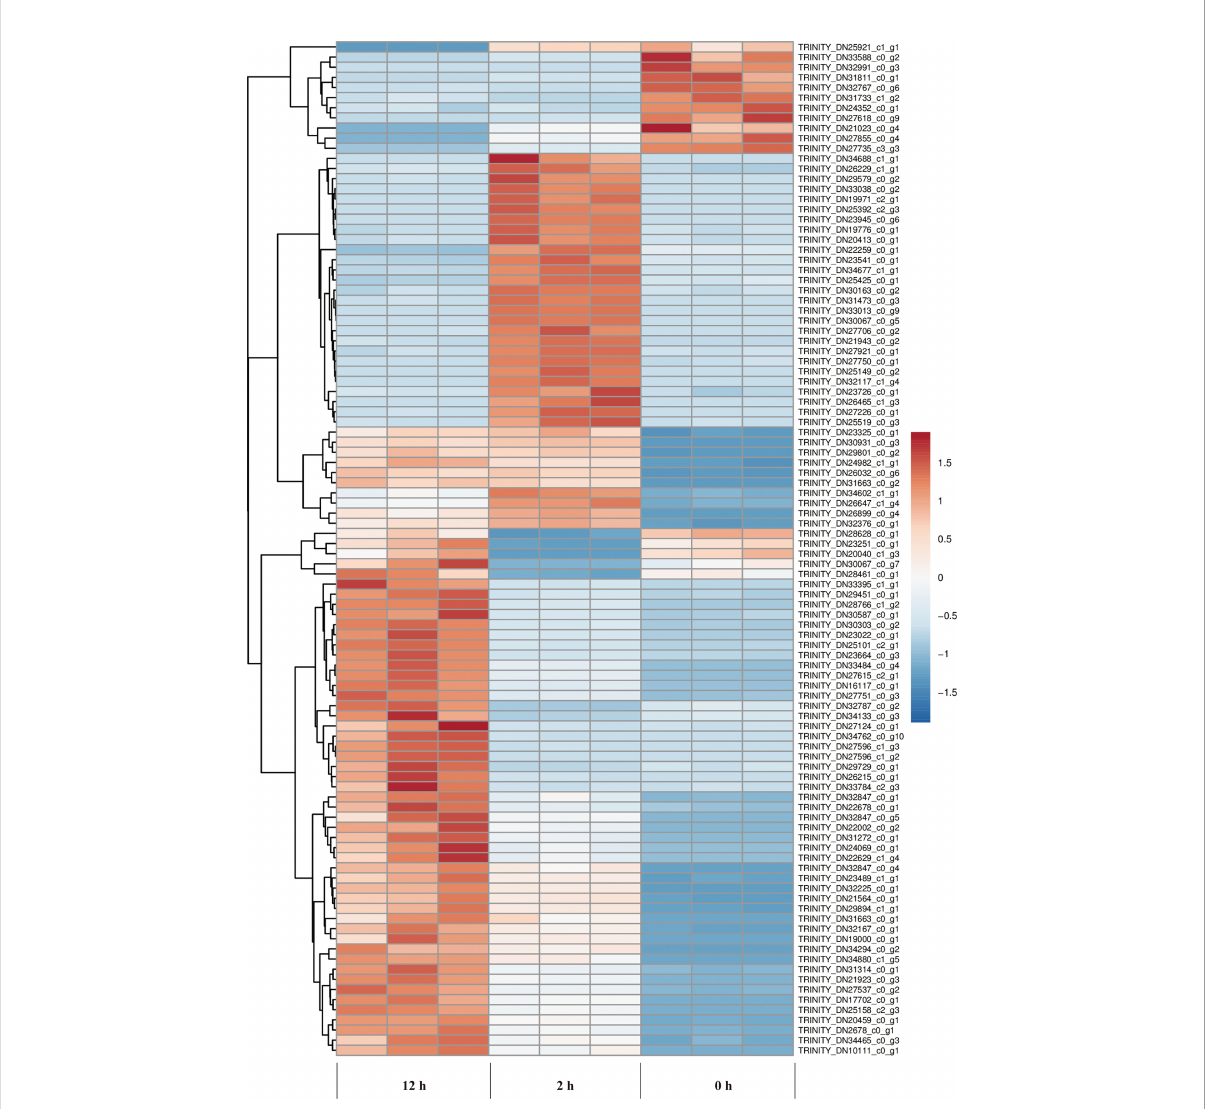
FIGURE 7 Cluster analysis of DEGs at different periods (0, 2, and 12 h) of salt stress. The abscissa represents the three independent biological replicates for the control (0 h), 2 h and 12 h duration of salt stress treatment, respectively. The ordinate represents the ID of a hundred genes with smallest p value. Color gradient from blue to red represents gene expression level from low to